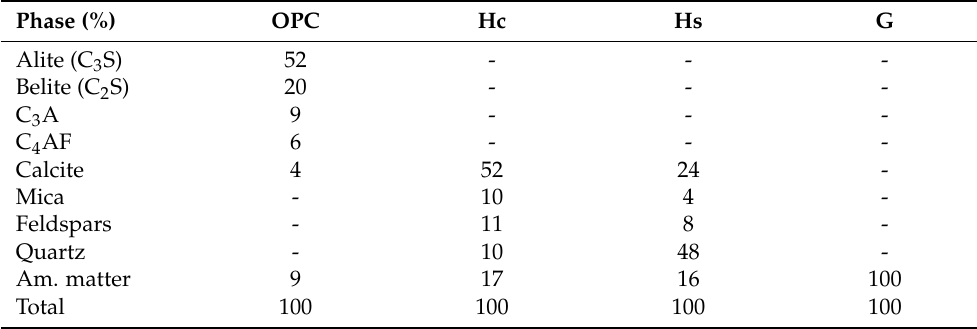
Table 1. Mineralogical composition of the materials quantified by the Rietveld